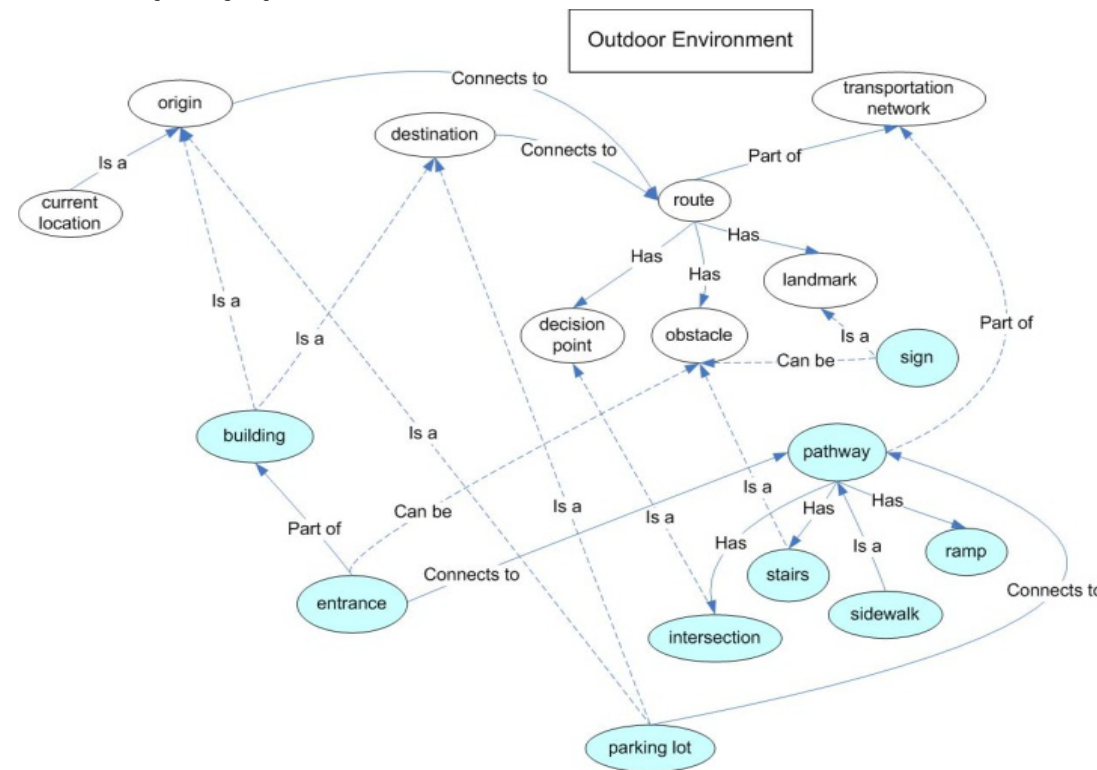
Figure 1. Ontology for outdoor